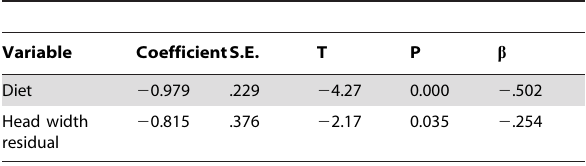
Table 3. Effects of diet and head width residual on number of bouts taken to perform the associative learning task.